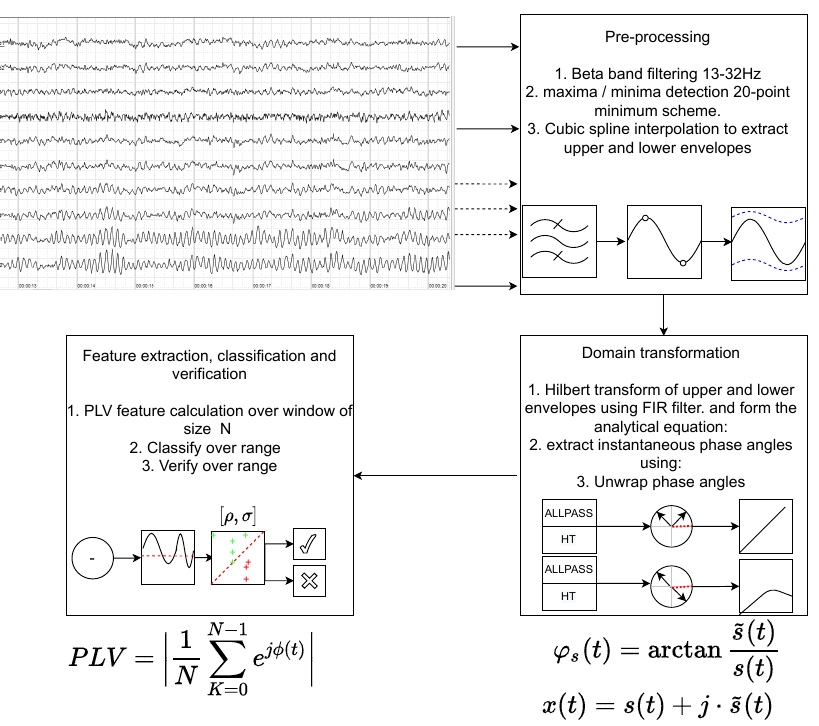
Figure 5. This figure shows an example overview of the full DSP process including the pre-processing, domain changes and feature extraction.